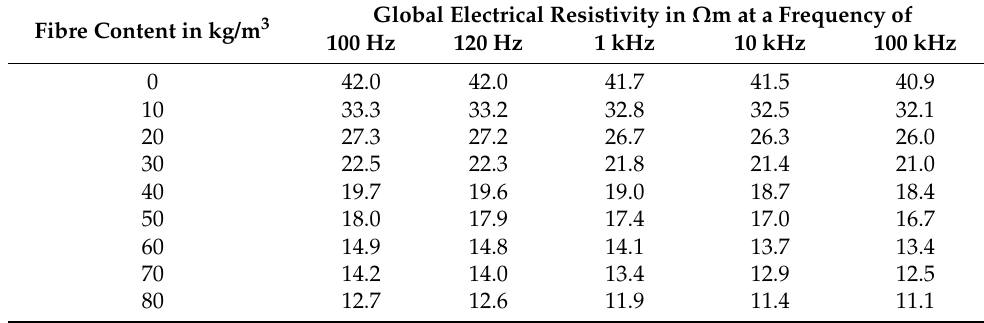
Table A29. Results of the resistivity measurements of the concrete mixture 42-55-330-00.